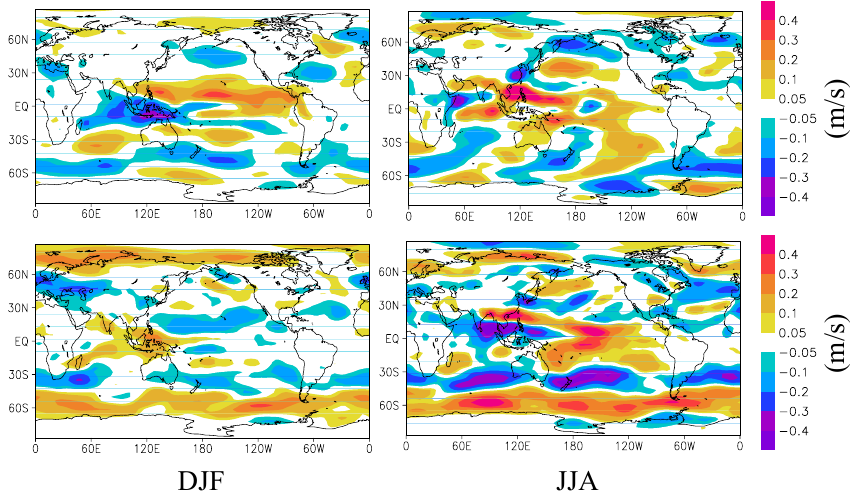
Fig. 6. Ensemble-mean measures of the sensitivity of the modeled error of the Niño 3.4 regression of zonal wind at 925hPa at WGust = 7 . 0 in boreal winter (December–February) on the left, and summer (June–August) on the right. The linear contribution a i is shown on top multiplied by µ i to give units of ms − 1 . The quadratic contribution b ii , similarly given as b ii µ 2 Max contributions added together represent the total difference between µ i